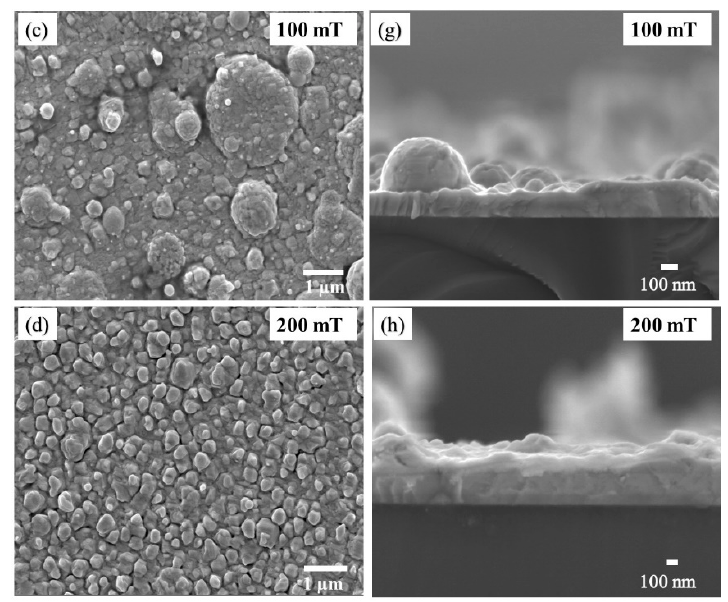
Figure 8. FESEM images ( a – d ) and cross-sections ( e – h ) of Bi 2 O 3 :Ho 3 + thin films deposited in the different oxygen partial pressures.